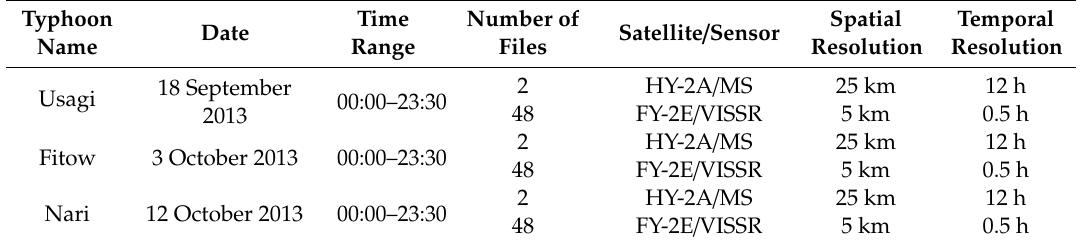
Table 1. Specific information about the HY-2A MS and FY-2E Visible and Infrared Spin Scanning Radiometer (VISSR) data.